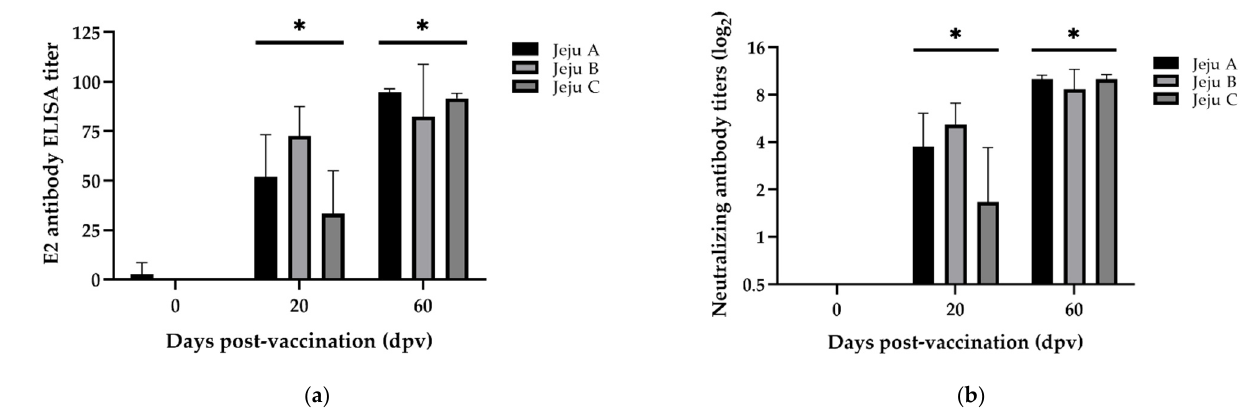
Figure 3. Serological analysis of serum samples from piglets on farms on Jeju Island. E2-specific ELISA ( a ) and neutralizing antibody titers ( b ) from the sera collected at 0, 20, and 60 dpv are presented. Bars represent the mean ± standard deviation (SD) during animal experiment period. * p < 0.05.